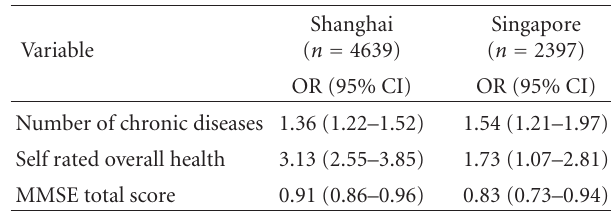
Table 3: Association between health factors and disability in Shang- hai and Singapore: stratified